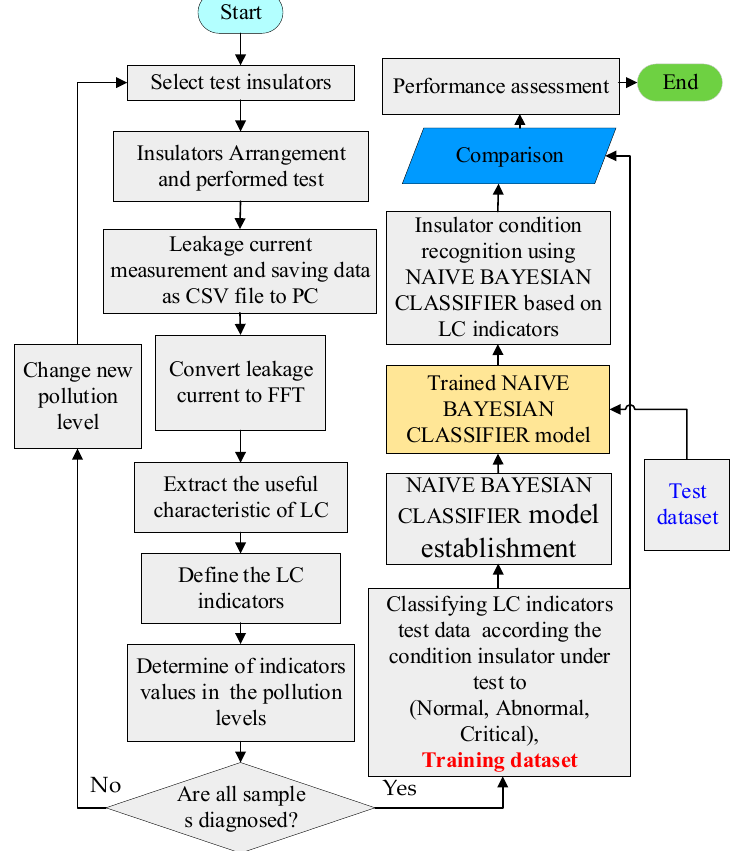
Figure 5. Data extraction and classification of the proposed indicators. Naïve Bayesian